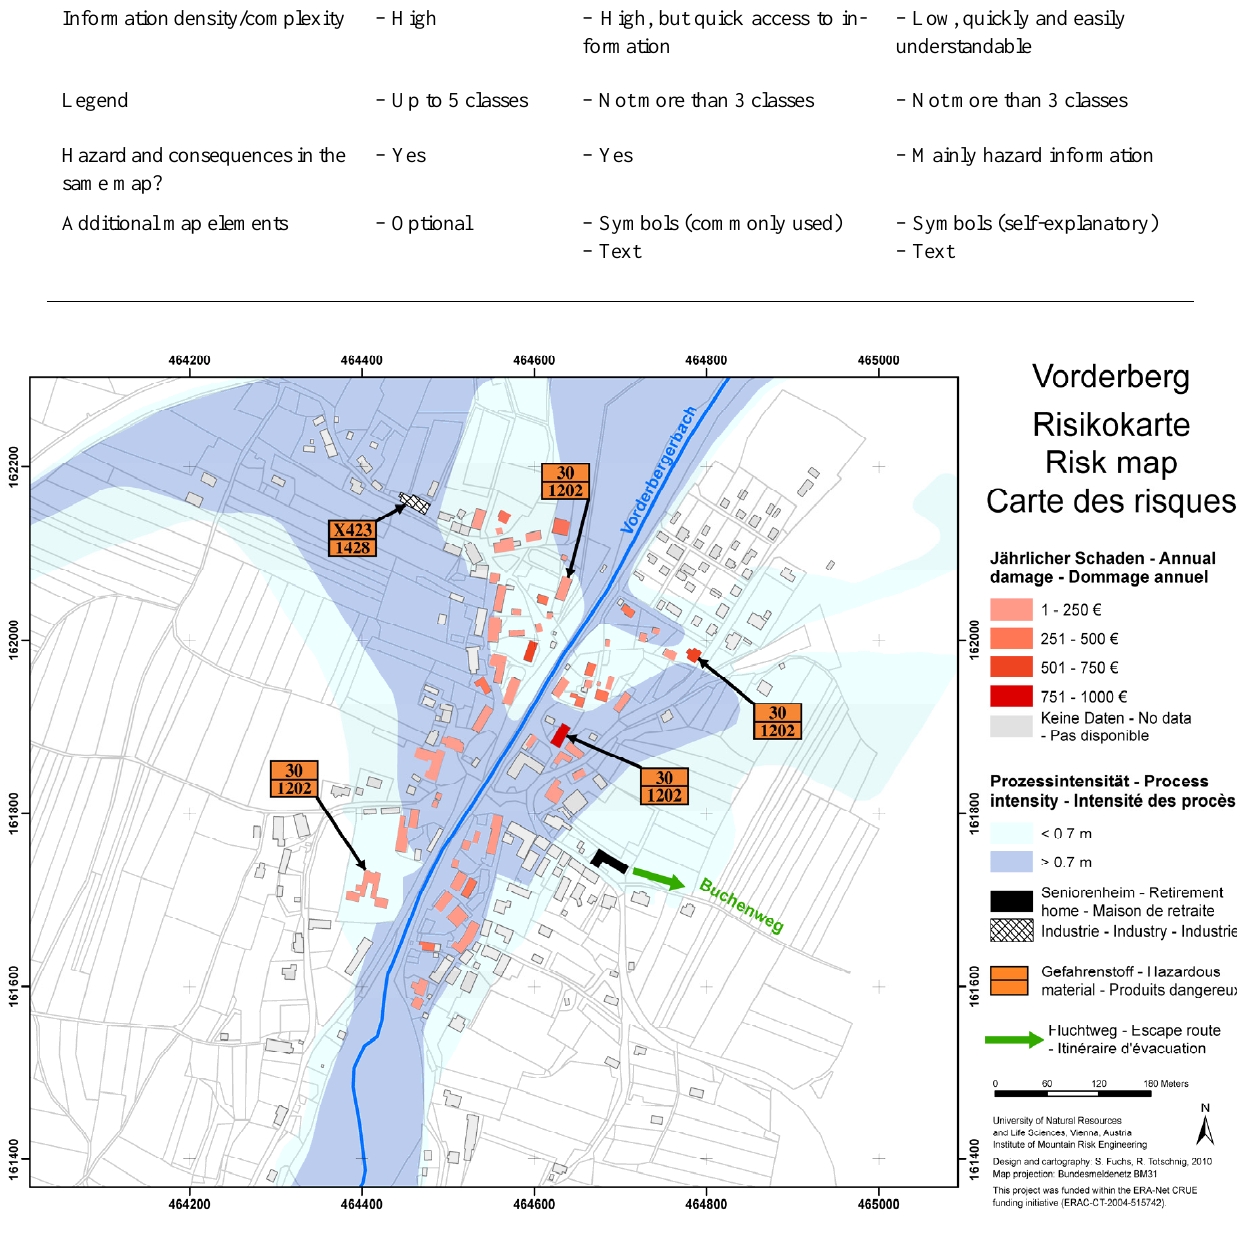
Figure 4: Map from the Austrian case study: This map was evaluated very good by test persons in the eye-tracking tests and the associated survey in terms of visualisation. Especially the symbols (hazardous material, evacuation route) attracted the eyes of test persons and were found useful by them.